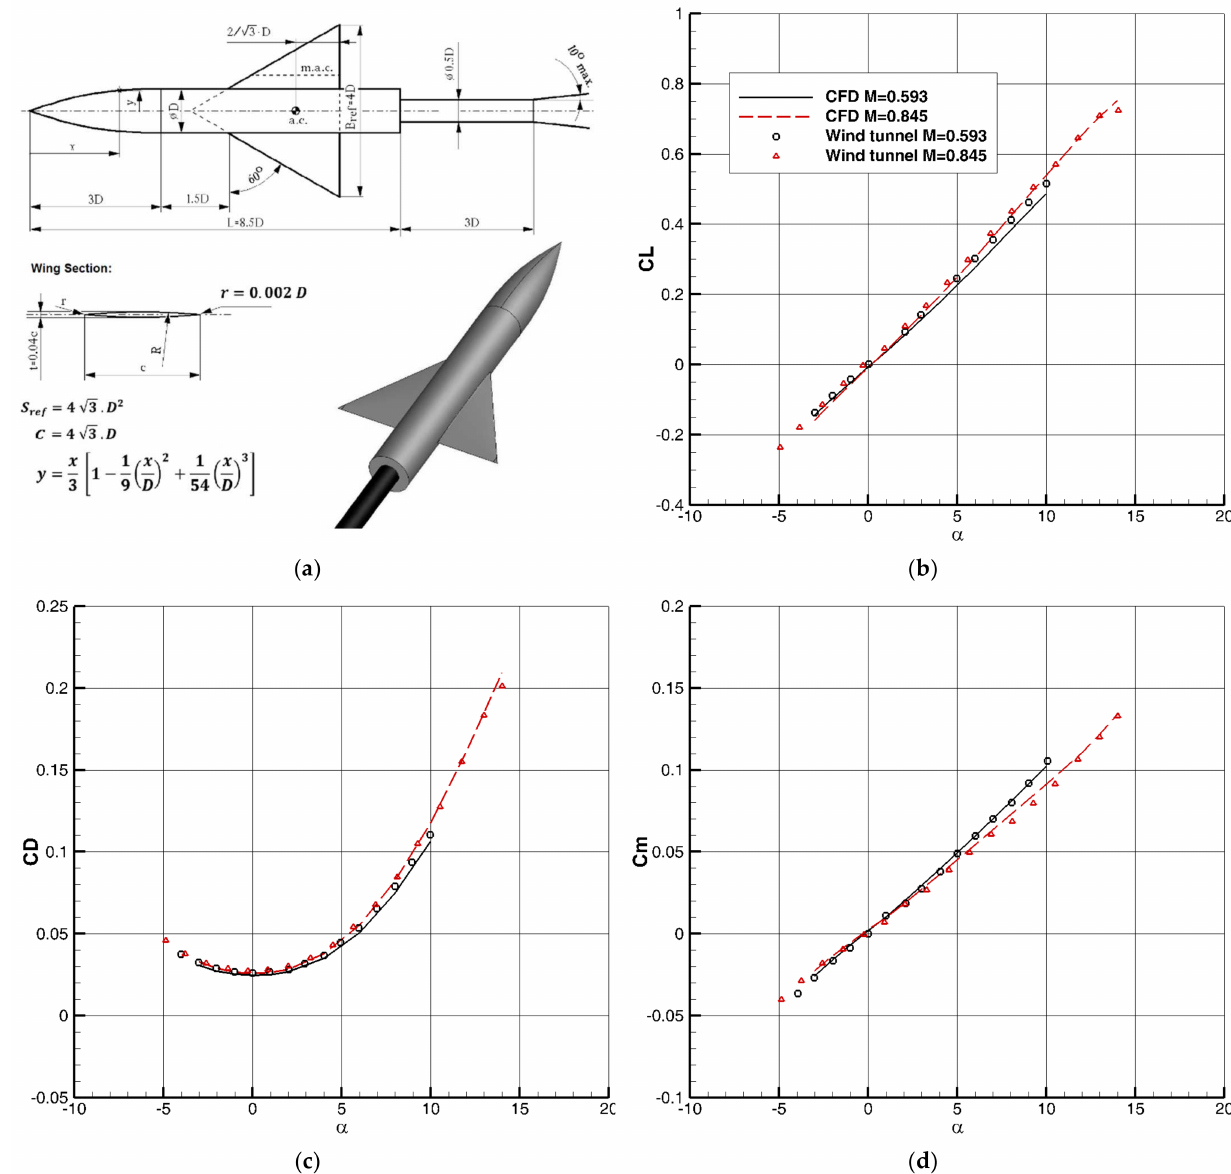
Figure 7. High-speed test case CFD validation: ( a ) AGARD-B model; ( b ) C L − α diagram; ( c ) C D − α diagram; ( d ) C m − α